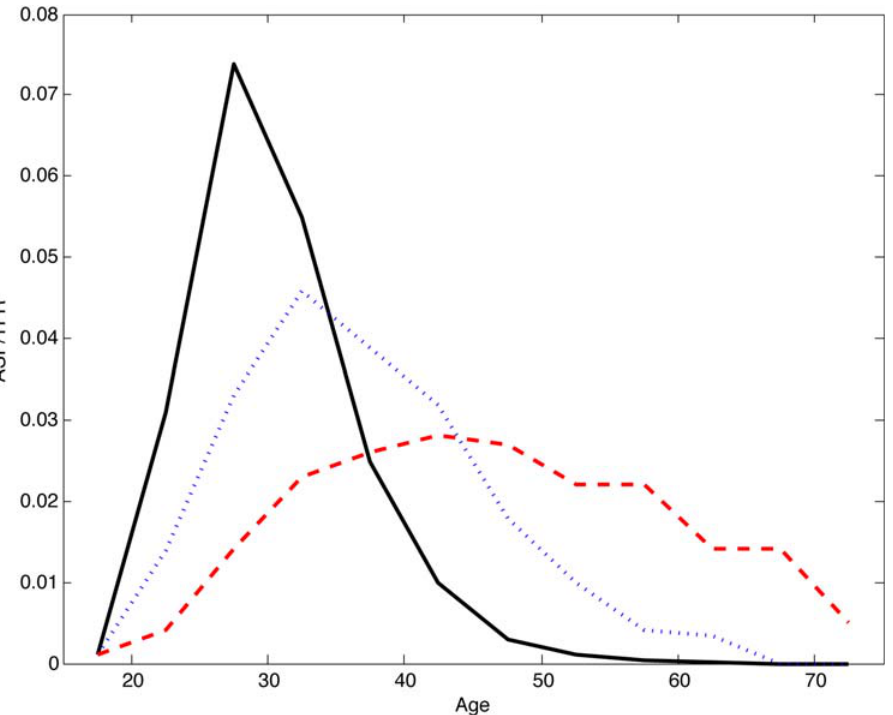
Figure 3. Three distinct male fertility distributions. Male fertility in1980 France (black), Pakistan 1984 (blue dots) and Cameroon 1964 (red dashes). Redrawn from Paget and Timaeus [24] Cameroon’s distribution is common of high-fertility polygynous societies. The Y-axis shows age-specific fertility rates as a fraction of the total fertility rate.